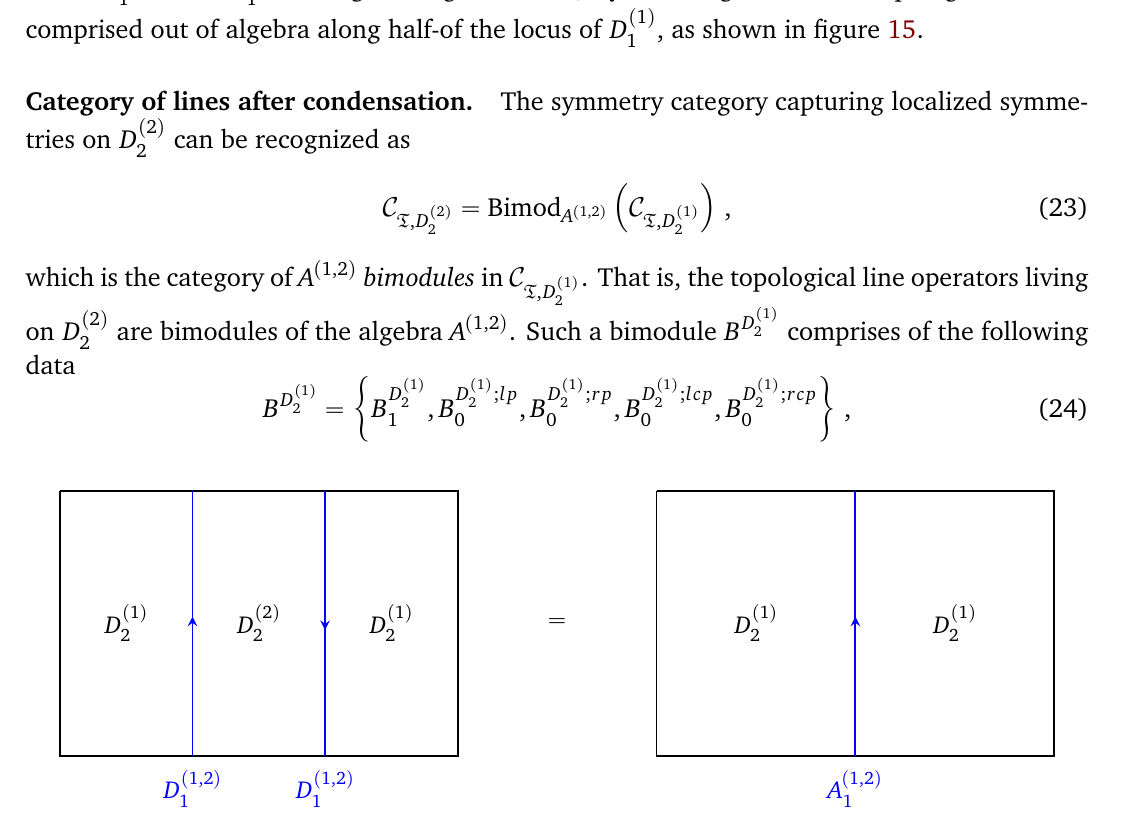
Figure 11: The construction of the object comprising the algebra implementing the gauging procedure to go from D p 1 q